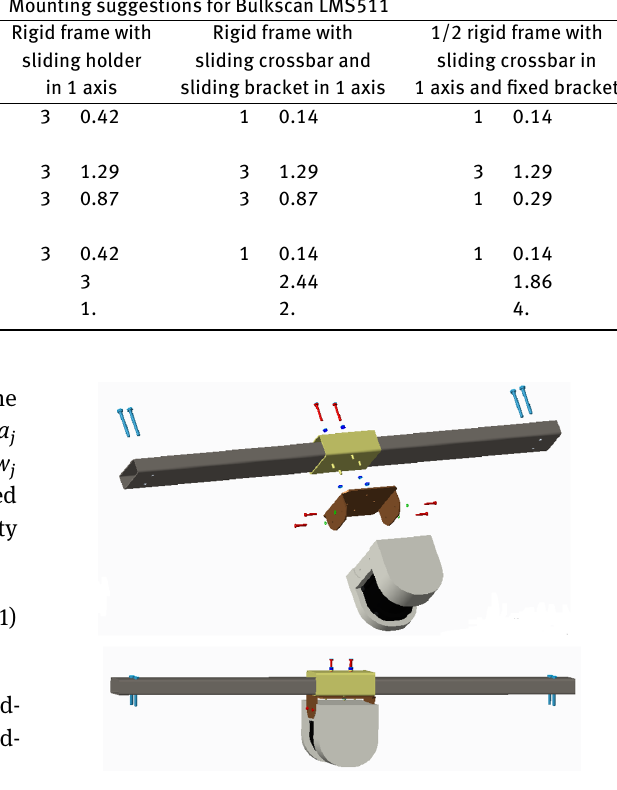
Figure 11: A 3D model of the proposed design variant